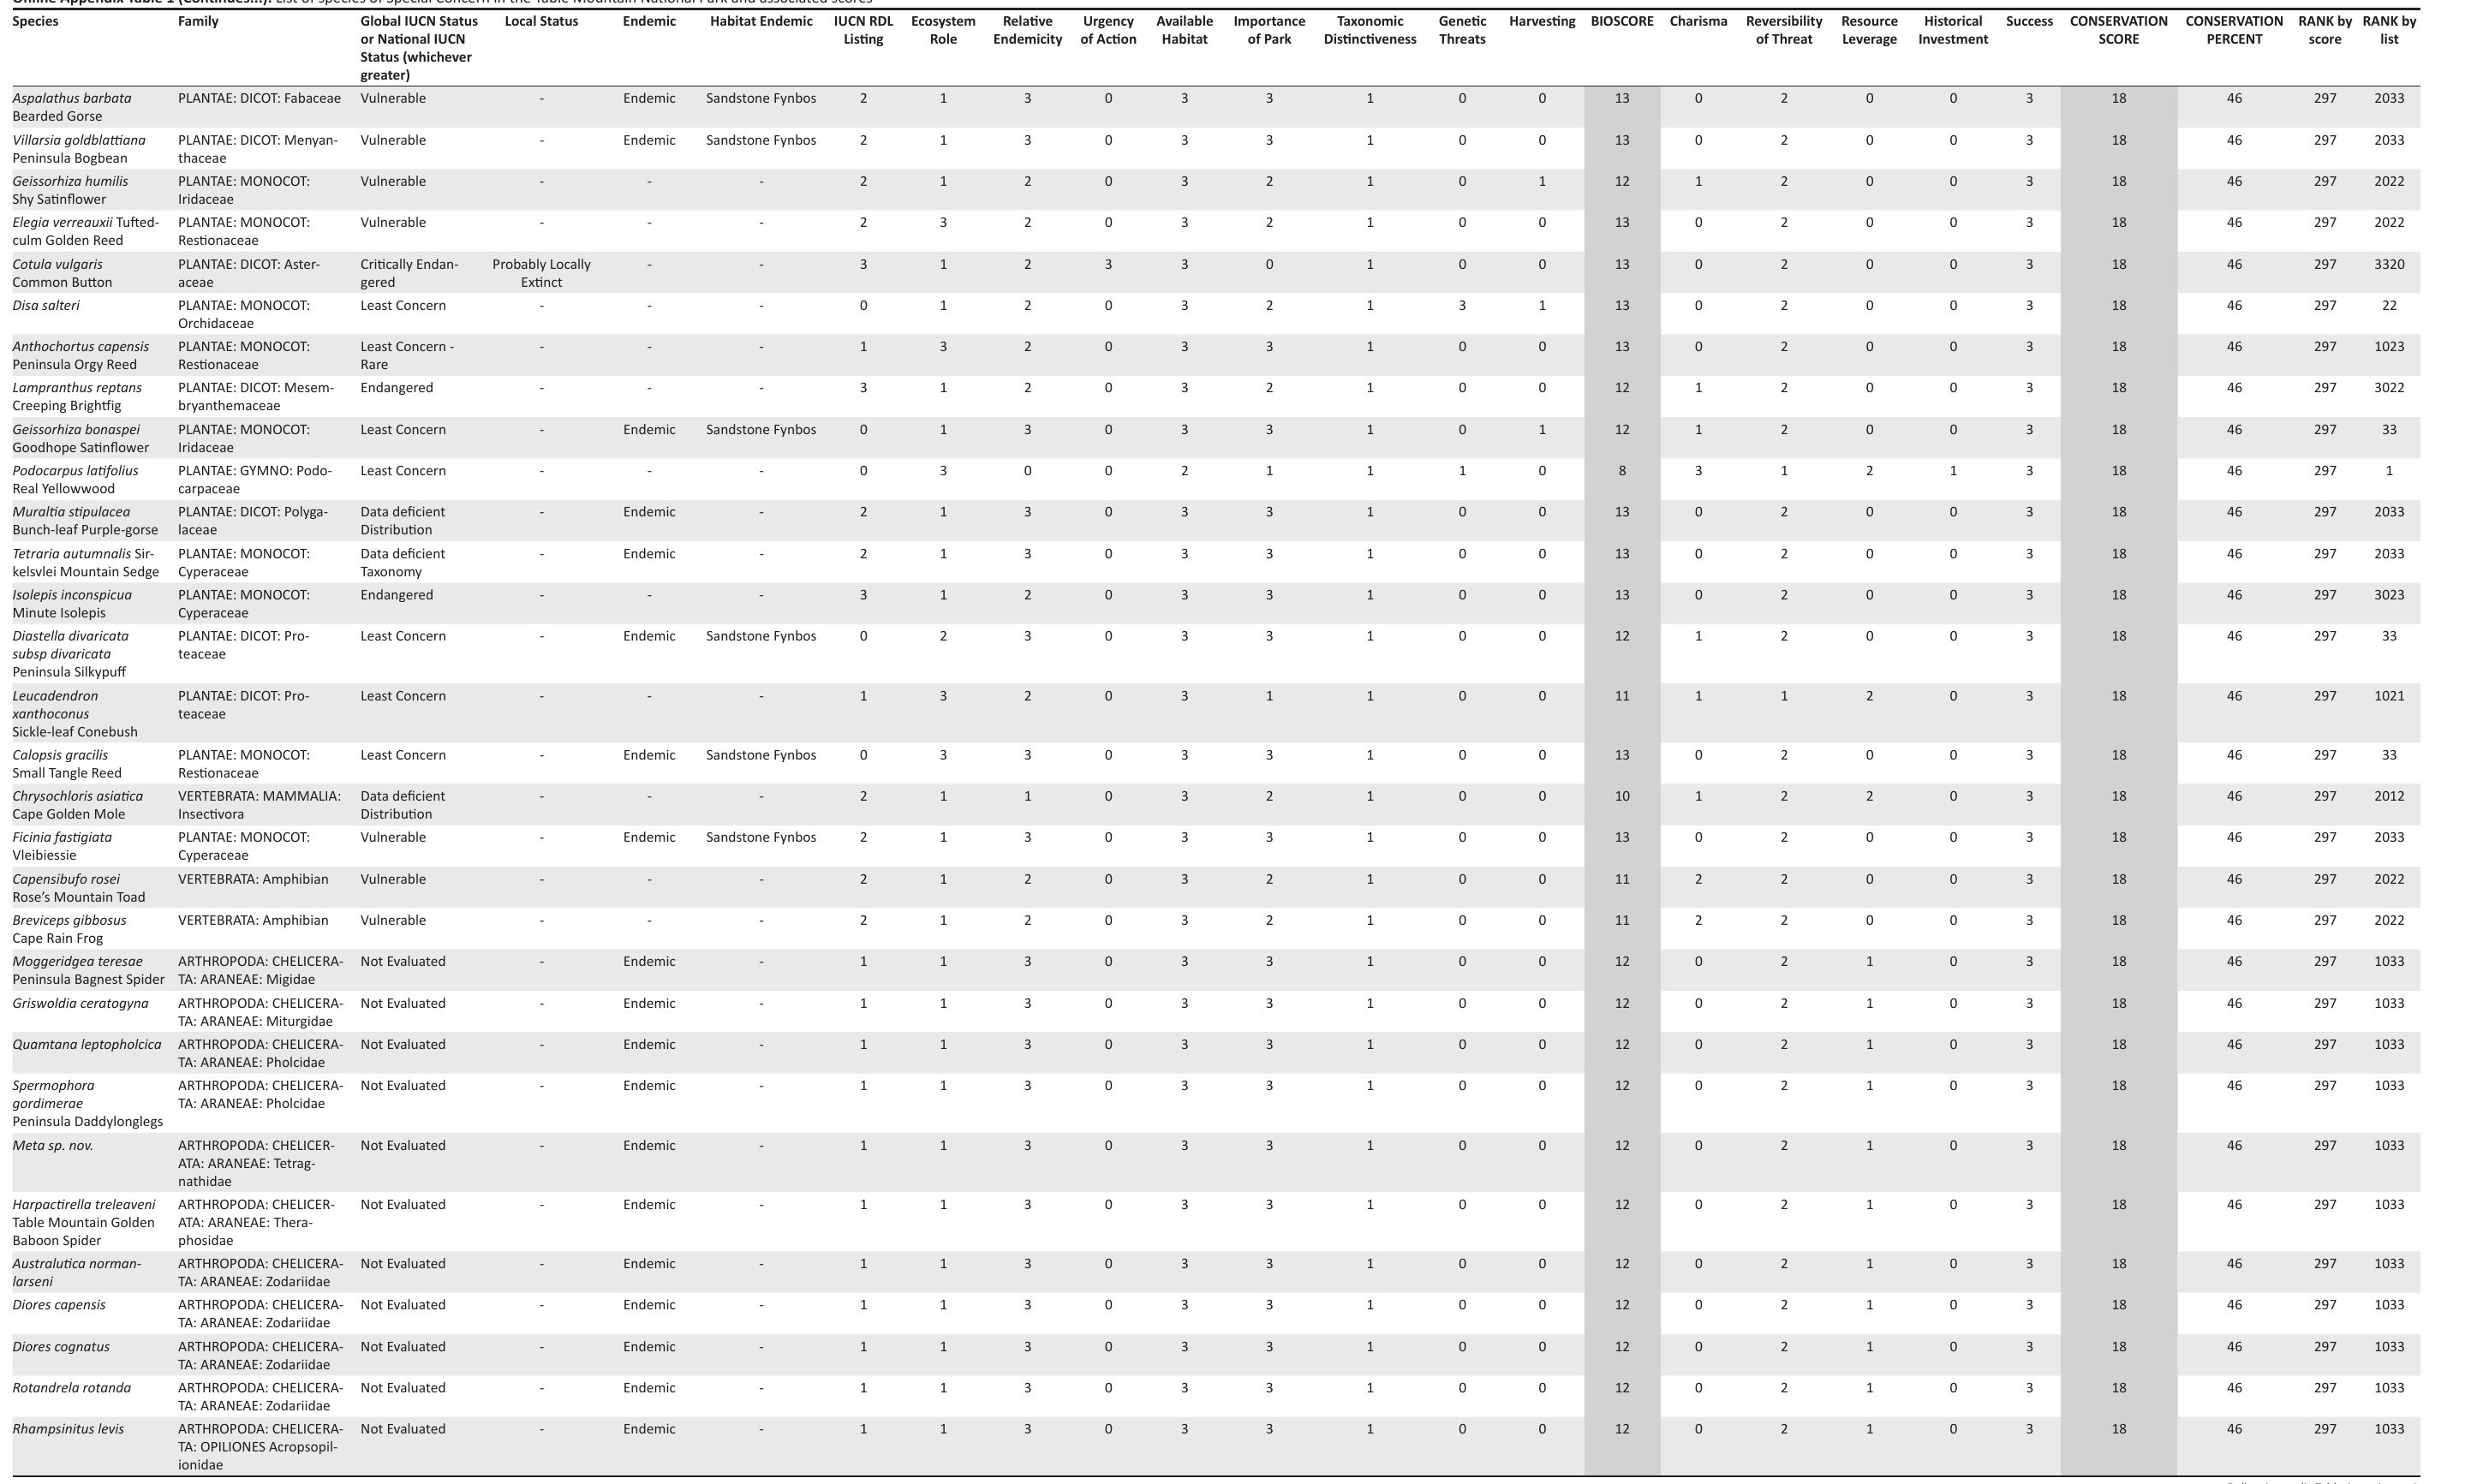
Online Appendix Table 1 (Continues...): List of species of Special Concern in the Table Mountain National Park and associated scores